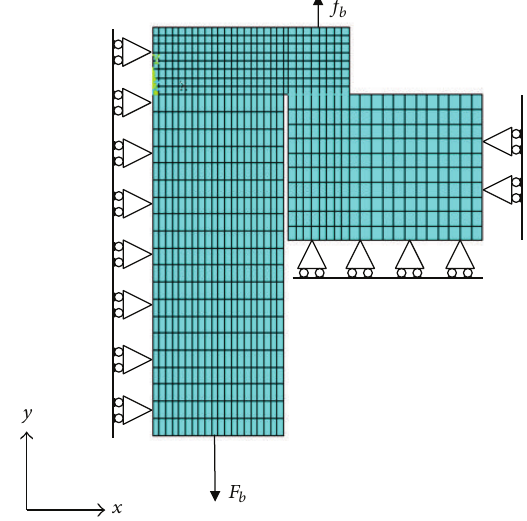
𝑦 -axis stress and deformation of joint under preload